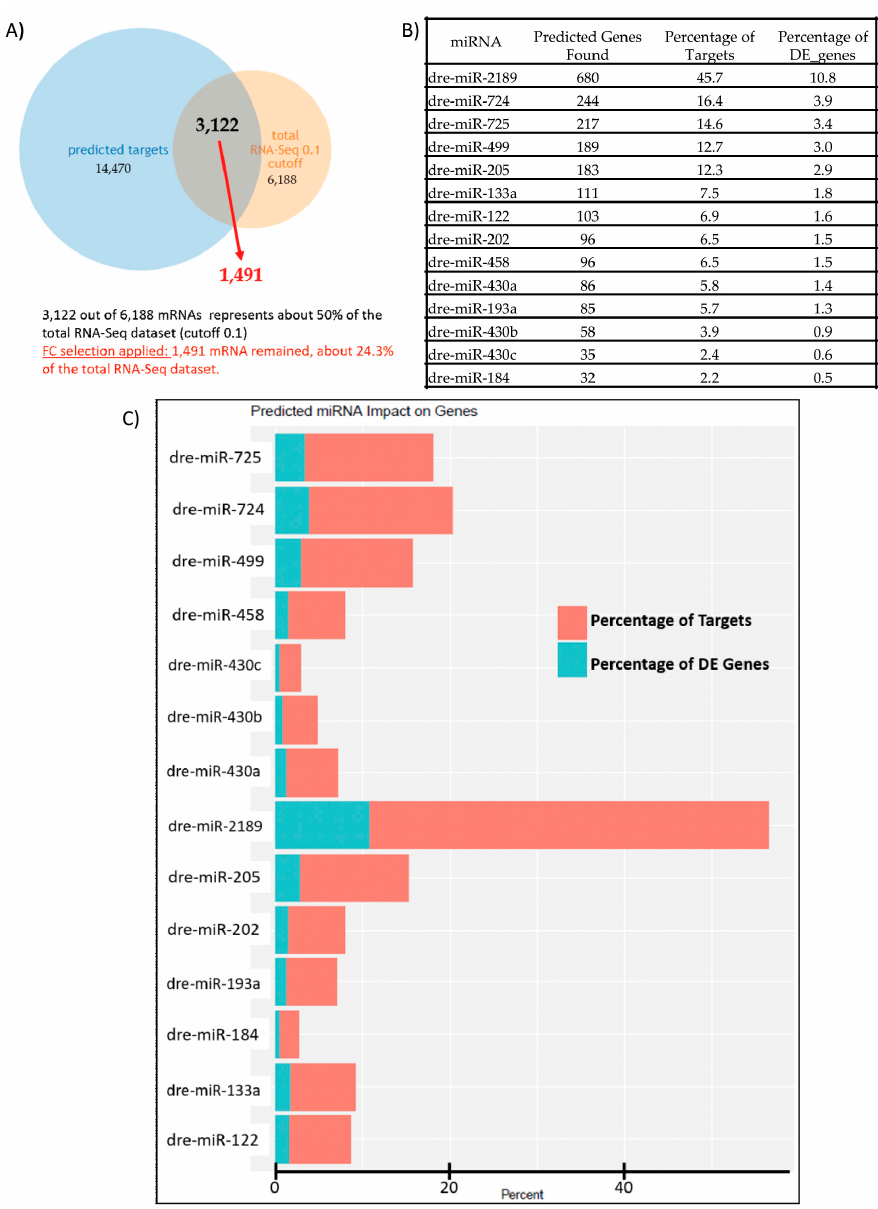
Figure 2. Comparison between predicted mRNA targets and differential expression (DE) mRNAs ( q ≤ 0.1) obtained from mRNA-Seq analysis. ( A ) Venn diagram comparing the 14,470 predicted mRNA targets obtained from TargetScanFish for all 15 miRNAs identified in Table 1 to the 6188 DE mRNAs in the mRNA-Seq dataset ( q ≤ 0.1). We found that 3122 mRNAs are common to both lists suggesting that together the 15 miRNAs deregulated by BPA target approximately 50% of the mRNAs DE in the mRNA-Seq data. After applying the FC criterion, 1491 mRNAs remained, suggesting that together the 15 miRNAs deregulated by BPA target approximately 24.3% of the mRNAs significantly DE in the mRNA-Seq dataset ( q ≤ 0.1); ( B ) For each of the 15 miRNAs identified in Table 1, the sum of the predicted genes found within the mRNA-Seq dataset ( q ≤ 0.1) was calculated as well the percentage of targets (relative to the 1491 target genes identified) and the percentage of DE genes (relative to the significant DE transcripts in the mRNA-Seq dataset ( q ≤ 0.1)) that this sum represents; ( C ) Bar plot representing the percentage of mRNA targets and DE genes.